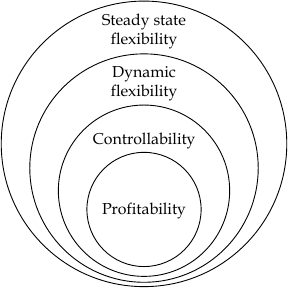
Figure 1. A Venn diagram representation of major operability indices and their relationship with process economics. It is interesting to note that the design optimization approaches started from the outermost layer, and with the advance of modeling techniques, they have progressed towards the center for guaranteed operability, which delivers the optimal process